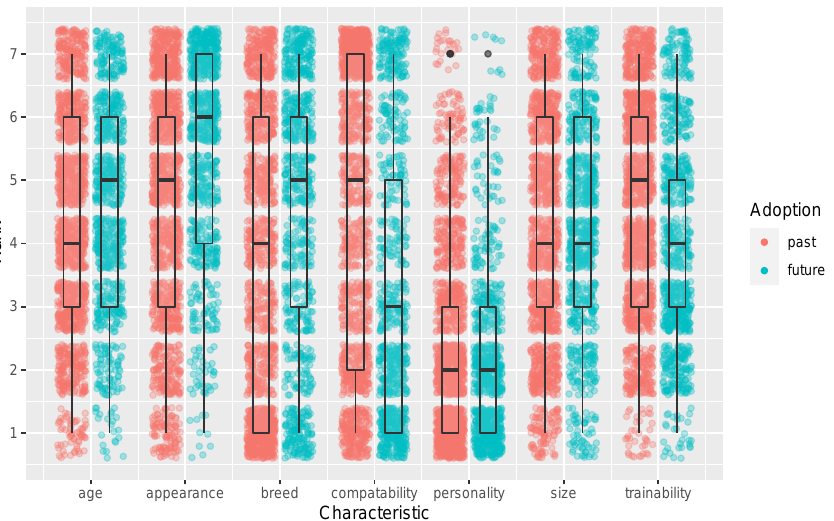
Figure 1. Jitter plot of characteristic rank positions for past and future adoptions. Box plots are overlaid to indicate quartiles and mean.